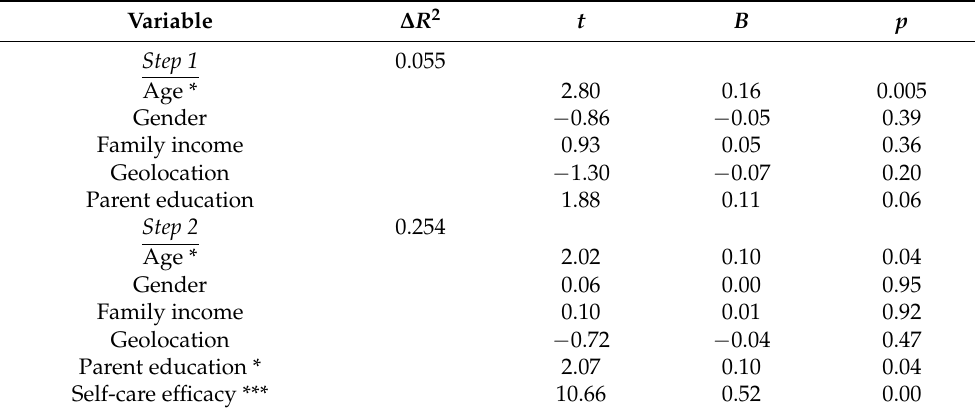
Table 4. Factors contributing to mental health while facing relationship